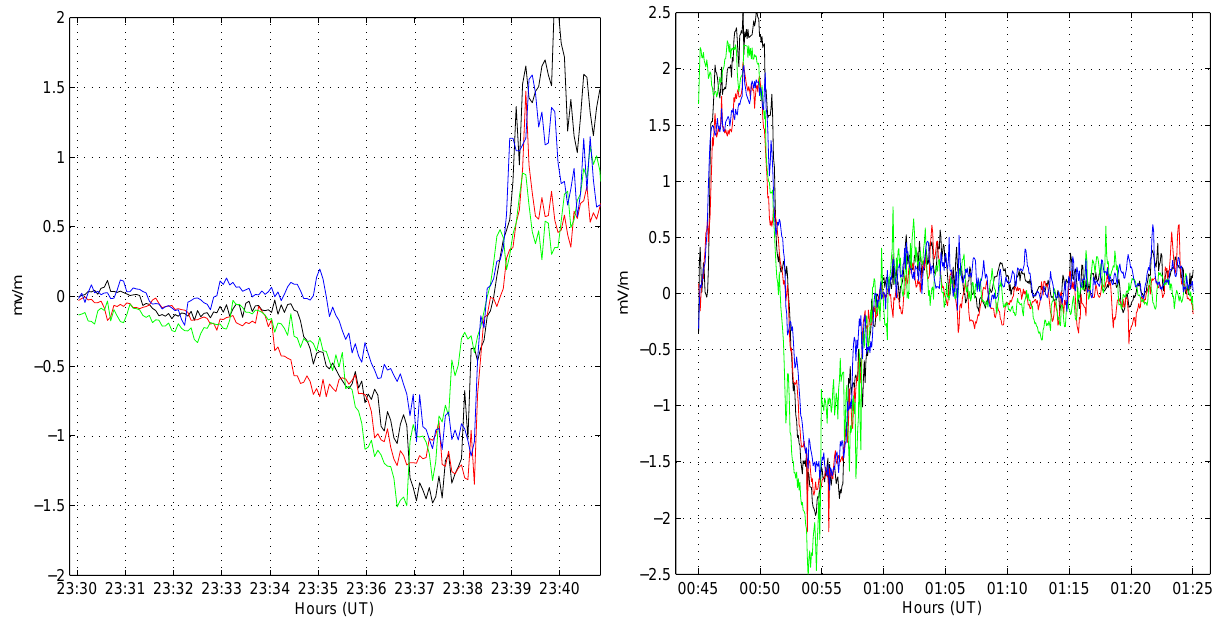
Fig. 8. (a) Duskward electric field measured by s/c 1 (black), s/c 2(red) s/c 3 (green), s/c 4 (blue) for the beginning of the event. (b) Same as in (a) but for the end of the